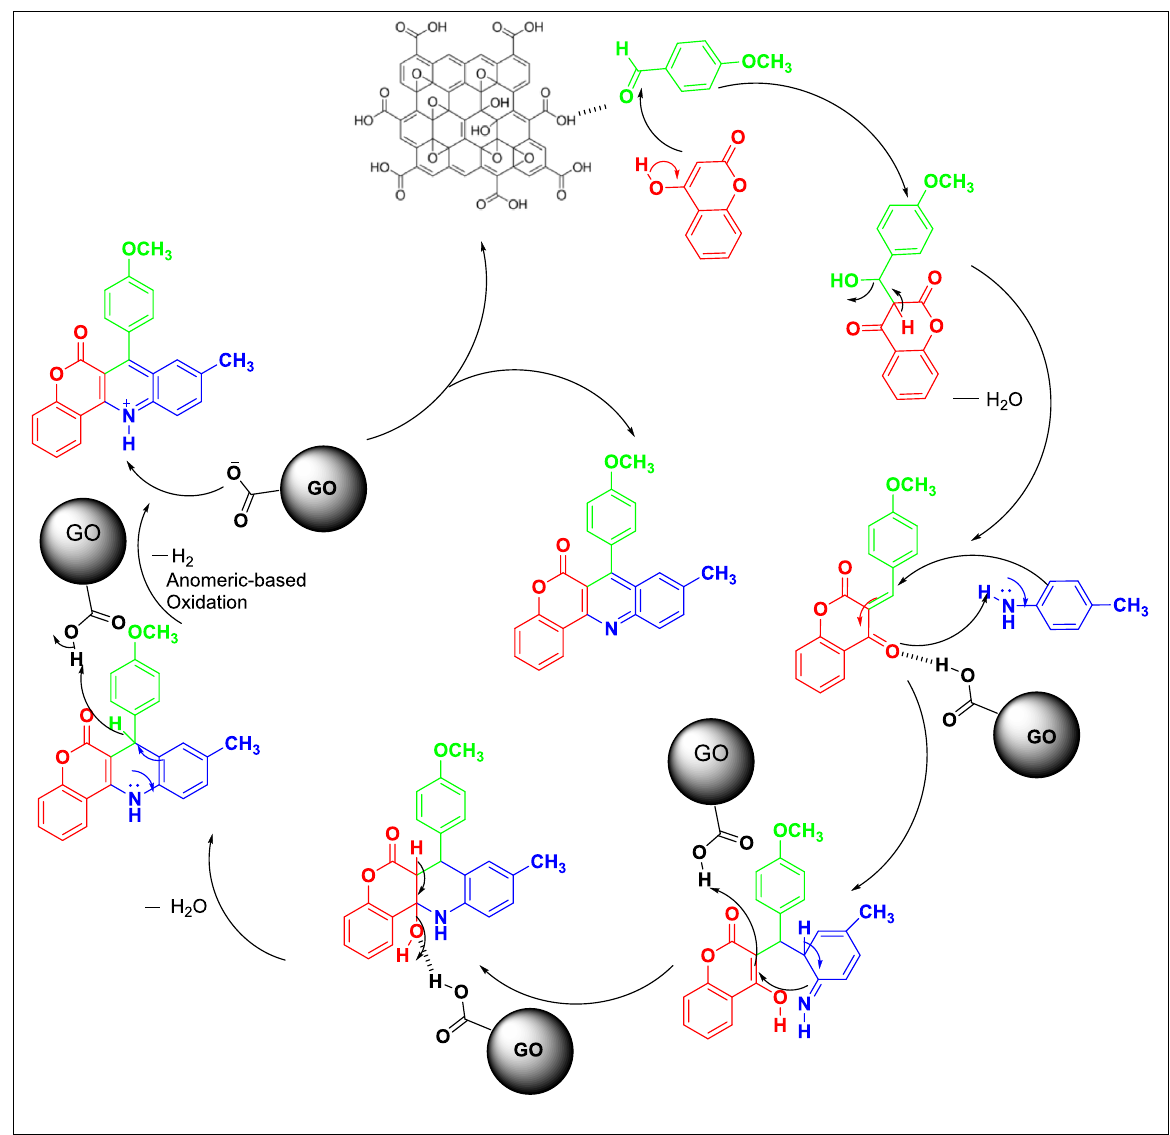
White solid, m.p: 272–273 °C; IR